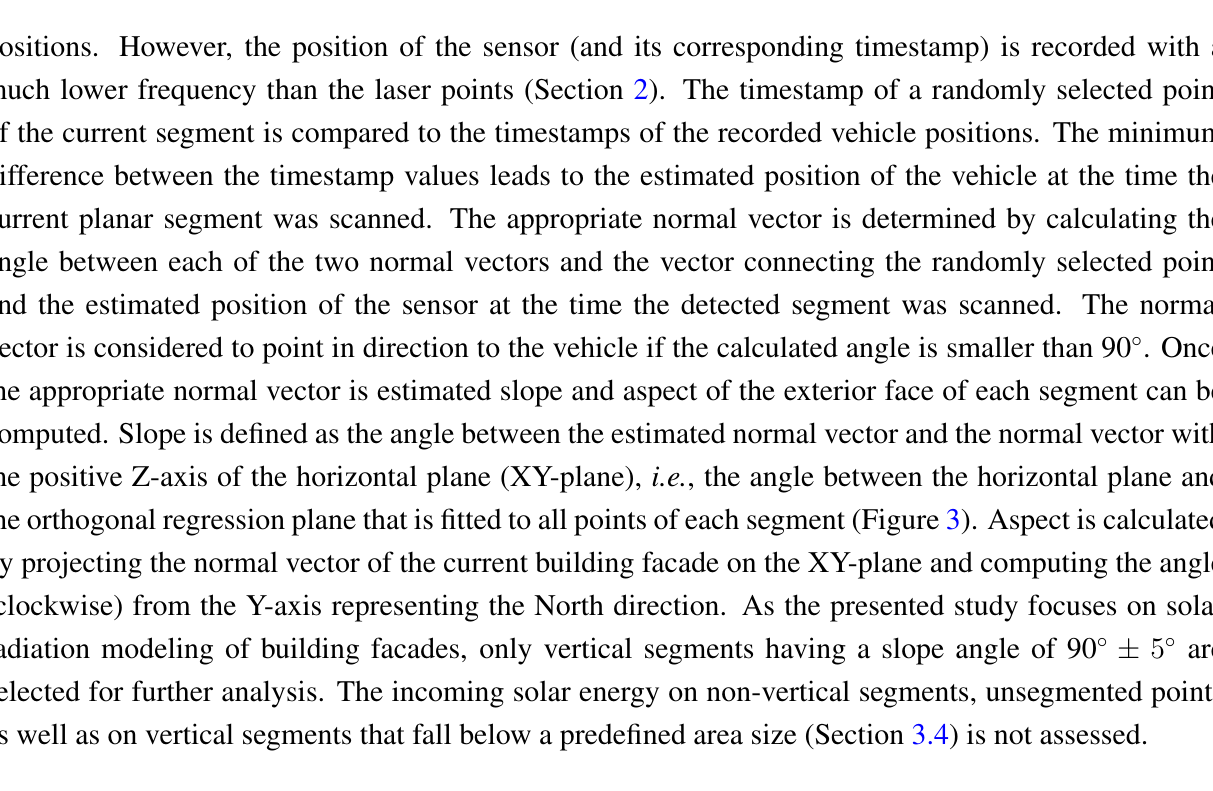
Figure 2. Classification of extracted wall segments according to their slope and aspect